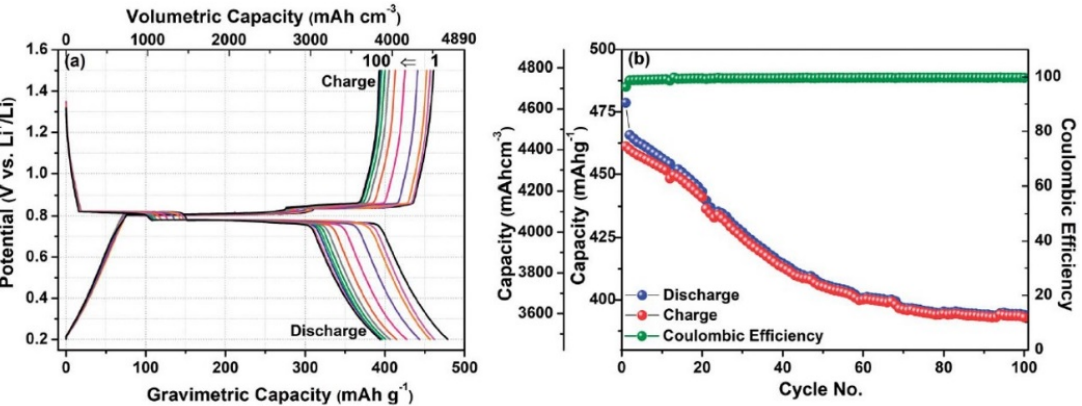
Figure 3. ( a ) Electrochemical charge-discharge of bulk Bi. ( b ) cyclic stability of bulk Bi [59]. Reproduced with permission. Copyright 2018, Royal Society of